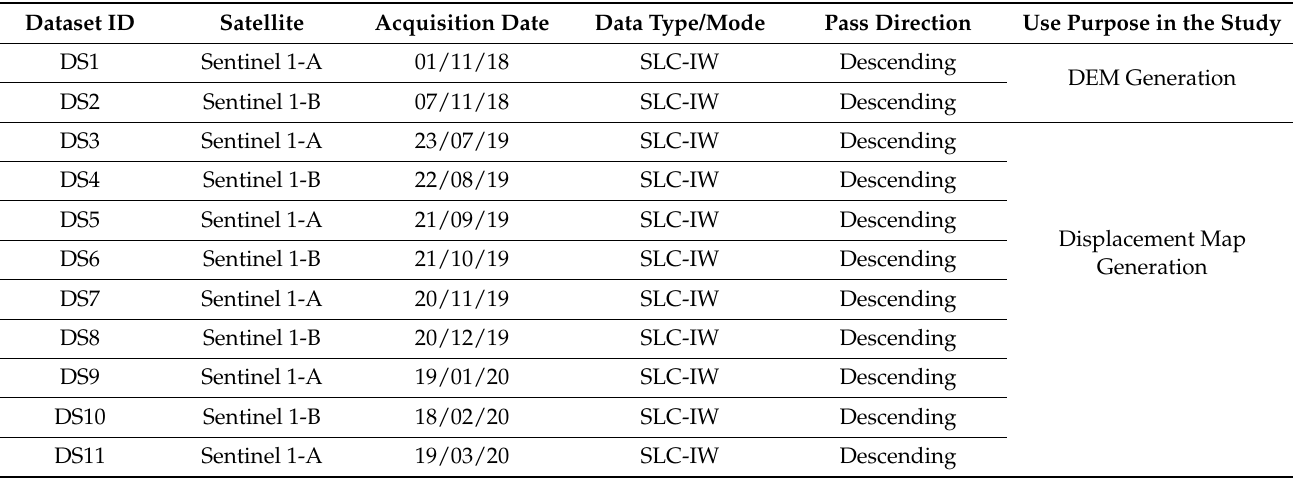
Table 2. Sentinel-1 datasets used in this study.